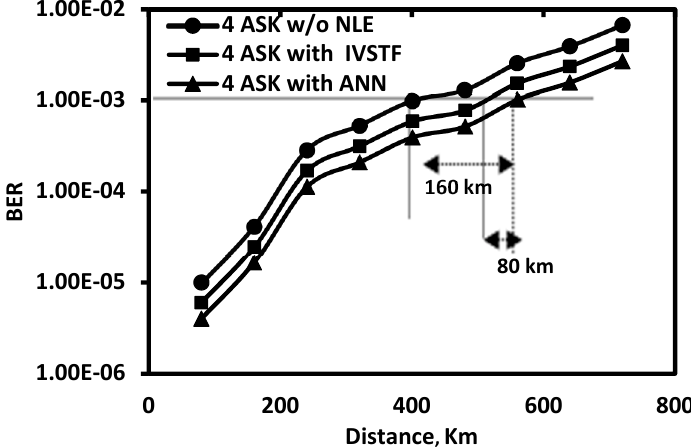
Figure 4. BER vs. transmission distance for 9.69-Gb / s optical Fast-OFDM at optimum launched optical power of − 6 dBm for Volterra-series transfer function (IVSTF) / ANN-NLEs and without (W / O) using NLE.